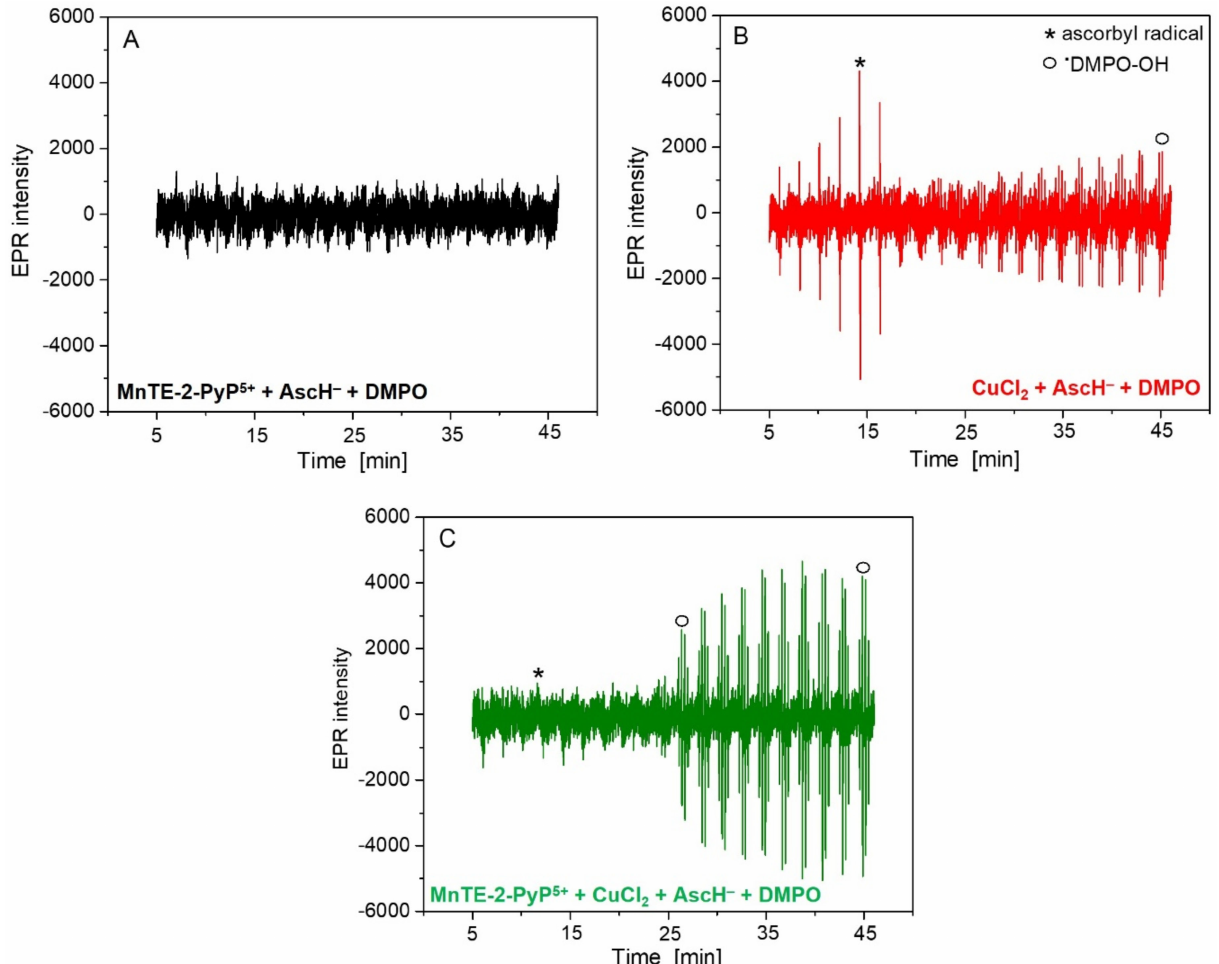
Figure 5. EPR spectra (20 spectra were measured, each consists of 3 scans) measured for ( A ) System 1 , ( B ) System 2 and ( C ) System 3 as described in Figure 5. (*—ascorbyl radical,